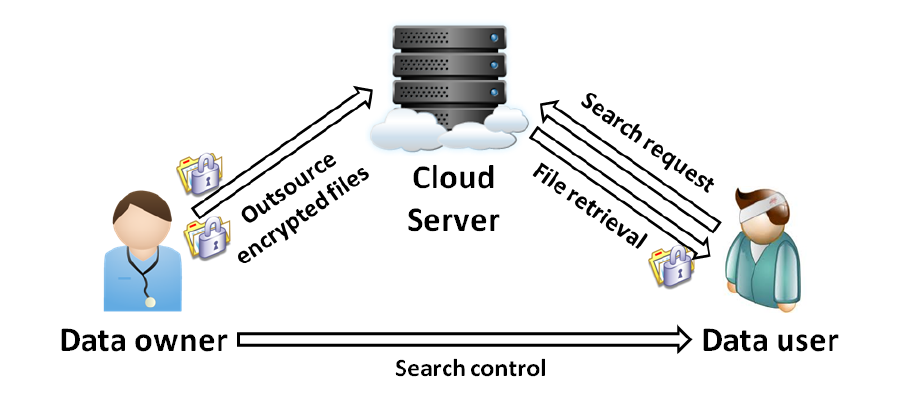
Figure 1. Cloud data hosting